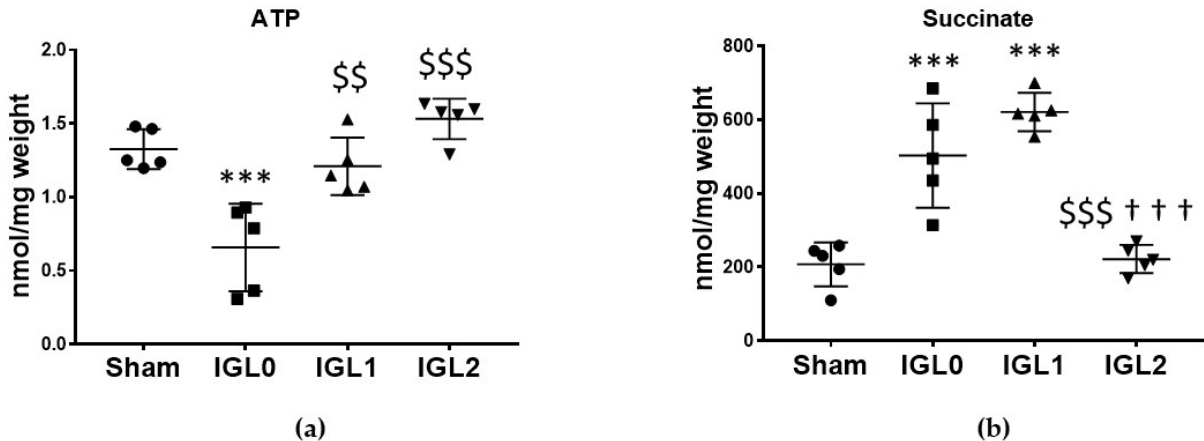
Figure 1. Energy metabolites as ATP ( a ) and succinate ( b ) in steatotic livers preserved (4 °C, 24 h) in the IGL-0, IGL-1, and IGL-2 solutions, vs. Sham. Bars represent mean values ± SDs of each group ( n = 5). Differences are shown comparing groups (* vs. Sham, $ vs. IGL-0, and † vs. IGL-1) according to the one-way ANOVA test and the Tukey post-hoc test (one symbol indicates p < 0.05; two symbols indicate p < 0.01; three symbols indicate p < 0.001).